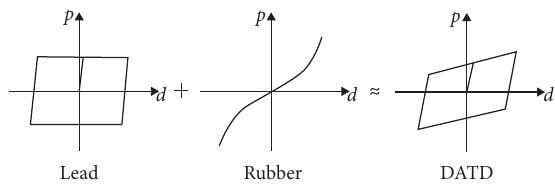
Figure 4: Restoring force model of the DATD.